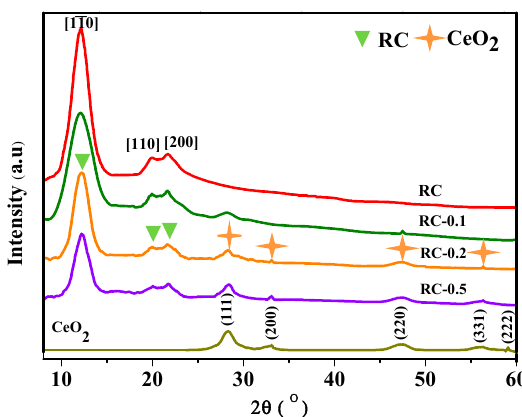
Figure 1. XRD patterns of pure regenerated cellulose (RC) film, CeO 2 nanoparticles (NPs) as well as cellulose/CeO 2 nanocomposite films with CeO 2 NPs generated from Ce(NO 3 ) 3 ·6H 2 O solutions.